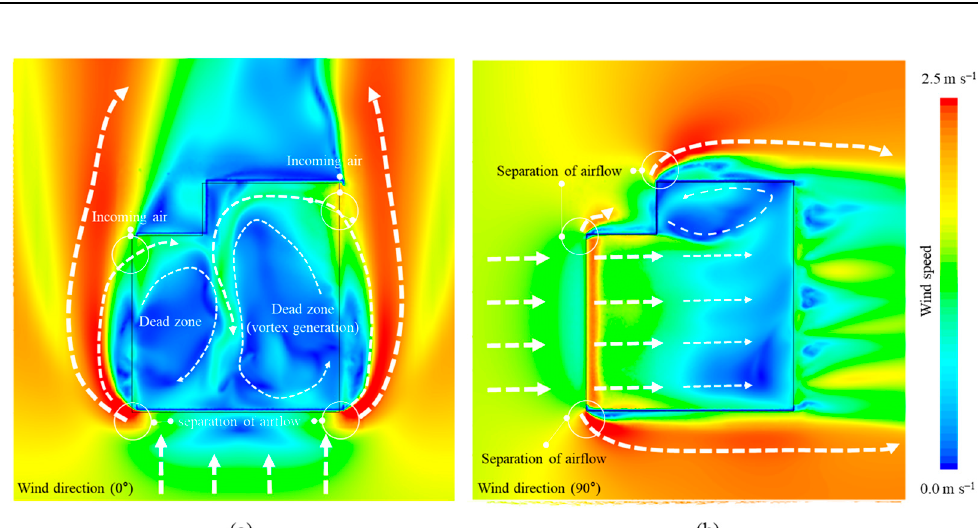
Figure 9. Airflow pattern inside and outside the greenhouse according to the WD: ( a ) 0 ◦ and ( b ) 90 ◦ . The average ventilation rate of the greenhouse when parallel, perpendicular, and diagonal to WD were generated was shown in Figure 10. On average, the natural ventilation of the greenhouse has a ventilation rate of 12.2 ACH when the WD (0 ◦ and 180 ◦ ) was parallel to the opening of the greenhouse. However, under conditions in which the WD was formed diagonally (45 ◦ , 135 ◦ , 225 ◦ , and 275 ◦ ), the average ACH was 43.8 ACH. The MFR flowing directly through the greenhouse opening was 3.6 times higher per hour because the air flowing through the opening was improved compared to the parallel wind conditions. Similarly, when the WD was generated perpendicular to the opening (WD 90 ◦ and 270 ◦ ), an average of 51.0 ACH was observed, and the ventilation rate per hour was 16.3% higher compared to the diagonal WD conditions. This was because the flow characteristics of the air coming diagonally generated a vortex and stagnant area (dead zone) inside the greenhouse. Lee et al. (2018) [57] mentioned that when the WD was formed 45 ◦ from the sidewall surface of the greenhouse, the ventilation rate was calculated to be rel- atively low because of the local vortex occurring inside the greenhouse.